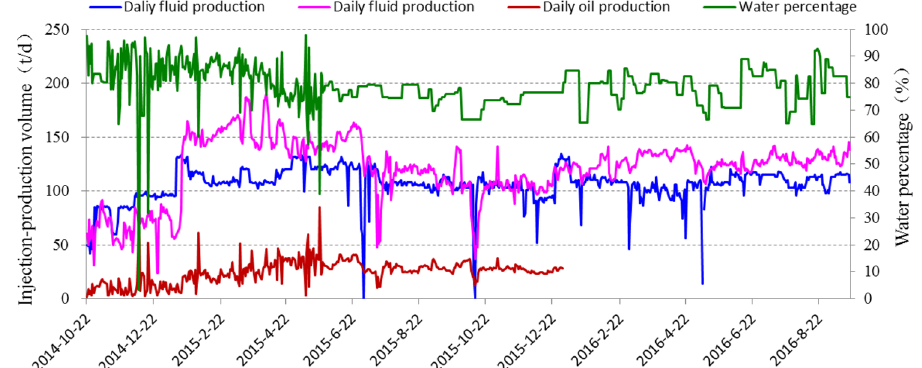
Fig. 11 Oil production curve of well FW2118 during SAGD